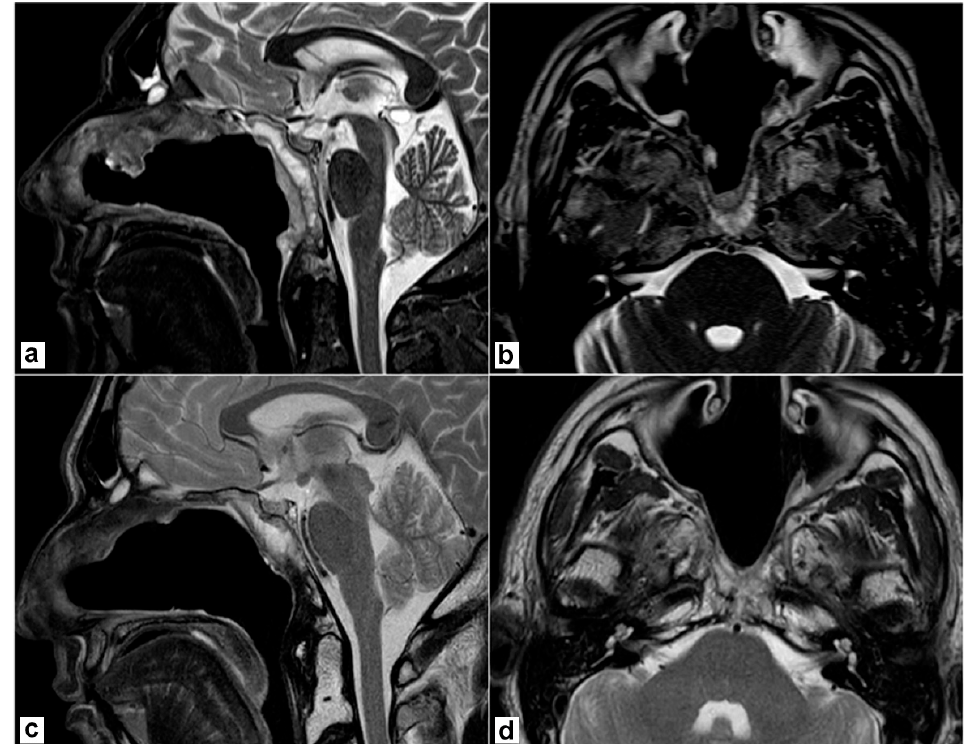
Figure 2. Postoperative magnetic resonance imaging (T2 weighted sequences). ( a , b ) 2 months after surgery, before proton therapy. No residual disease is detectable; the nasoseptal flap is vital. ( c , d ) 2 years after surgery. No recurrence is detectable; the post-radiotherapy scar is evident.